Question: Briefly state, in one sentence, what is plotted here.
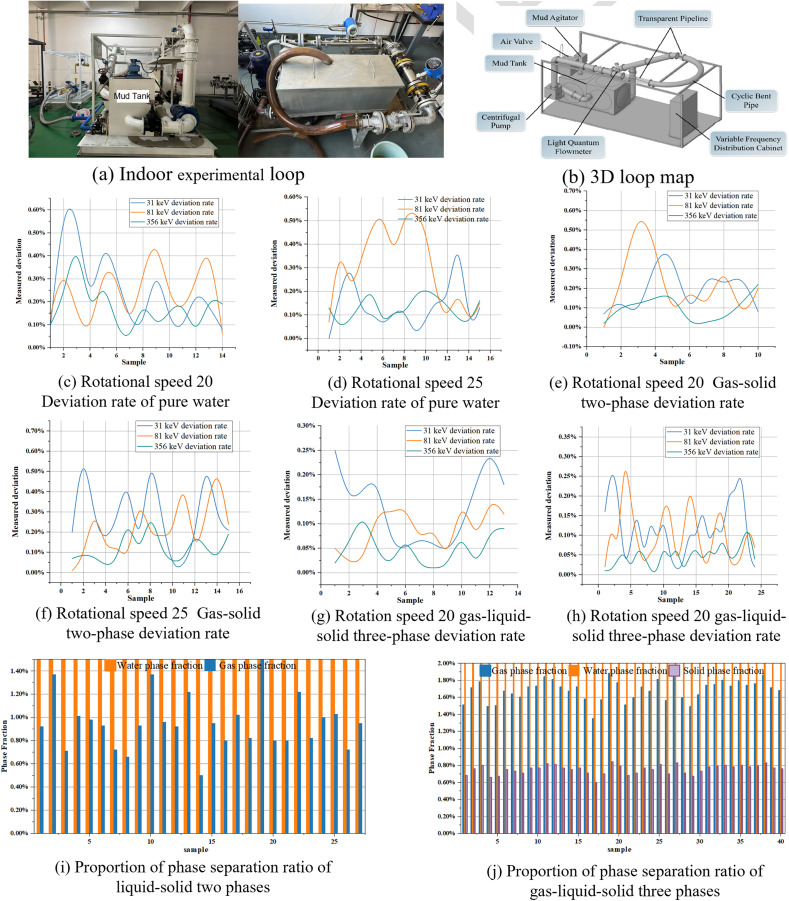
Answer: This group of figures shows the indoor experimental setup and test results of the multiphase flow gamma ray measurement system. (a)-(b) show the physical drawing and 3D structure diagram of the experimental bench respectively; (c)-(h) show the deviation rate time series curves of 31 keV, 81 keV and 356 keV energy segments under six working conditions. (i)–(j) present the bar charts of the measured gas-, water- and solid-phase fraction results under the corresponding working conditions. They show that the phase fractions inverted from the three energy segments agree closely with the set reference values across all conditions, with the deviation of each phase kept within the calibration tolerance, which visually confirms the accuracy of the phase-separation inversion under the indoor standard conditions.